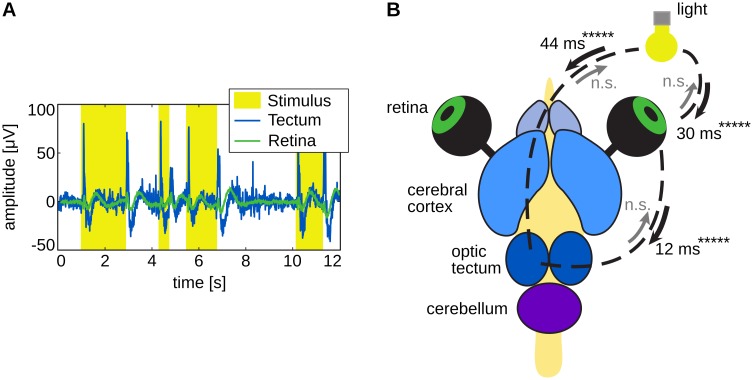
Directed interactions in the turtle brain during visual stimulation with random light pulses (modified from [19], creative common attribution license CC BY).(A) Raw traces recorded in the tectum (blue) and from the retina (green) overlaid on the light pulses (yellow). (B) Turtle brain explant with eyes attached. Transfer entropy was found from the retina of the right eye to the left tectum, as well as from the light source (yellow) to the retina and to the tectum (***** denotes p < 10(−5)). P-values for the opposite directions were not significant (n.s.). Note, that the interaction between light source and optic tectum shows a interaction delay roughly equal to the summed interaction delay between light source and retina and retina and optic tectum (deviation ≤ 5%).